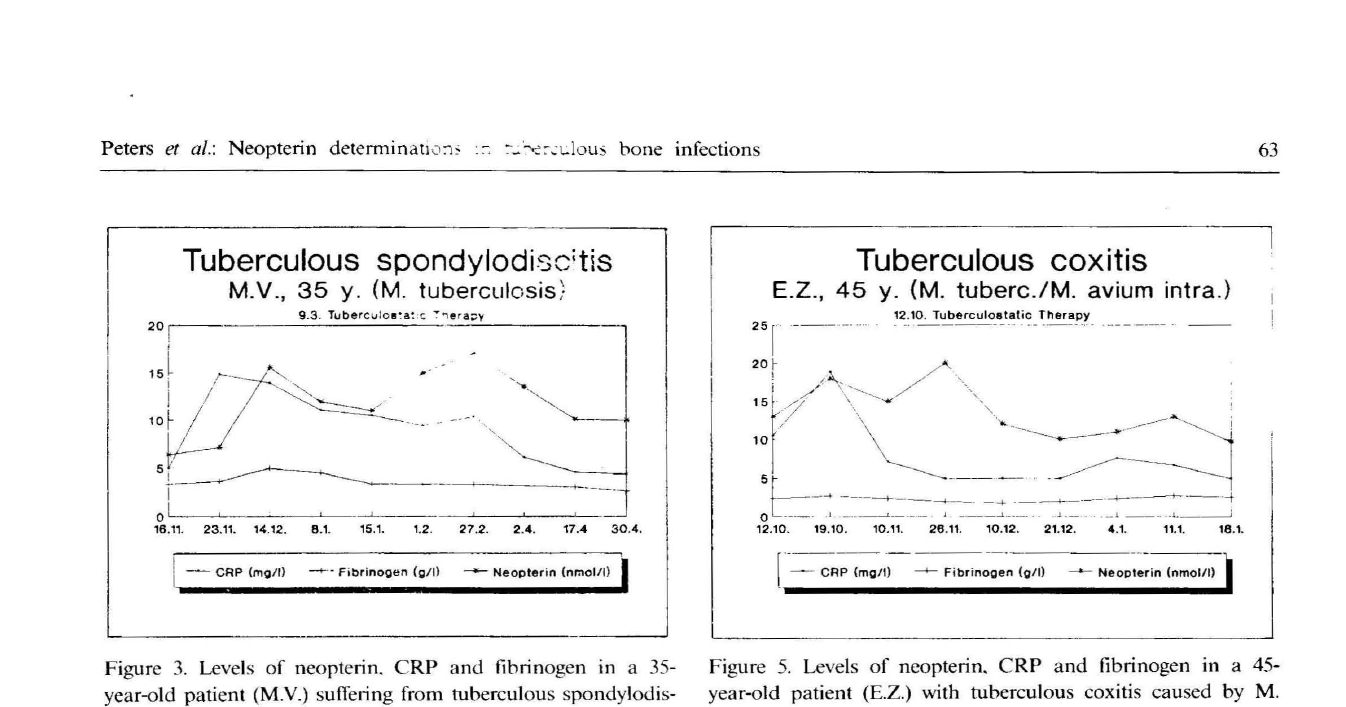
Figure 3. Levels of neopterin. CRP and fibrinogen in a 35- year-old patient (MV) suffering from tuberculous spondylodis citis before and after antituberculous therapy.